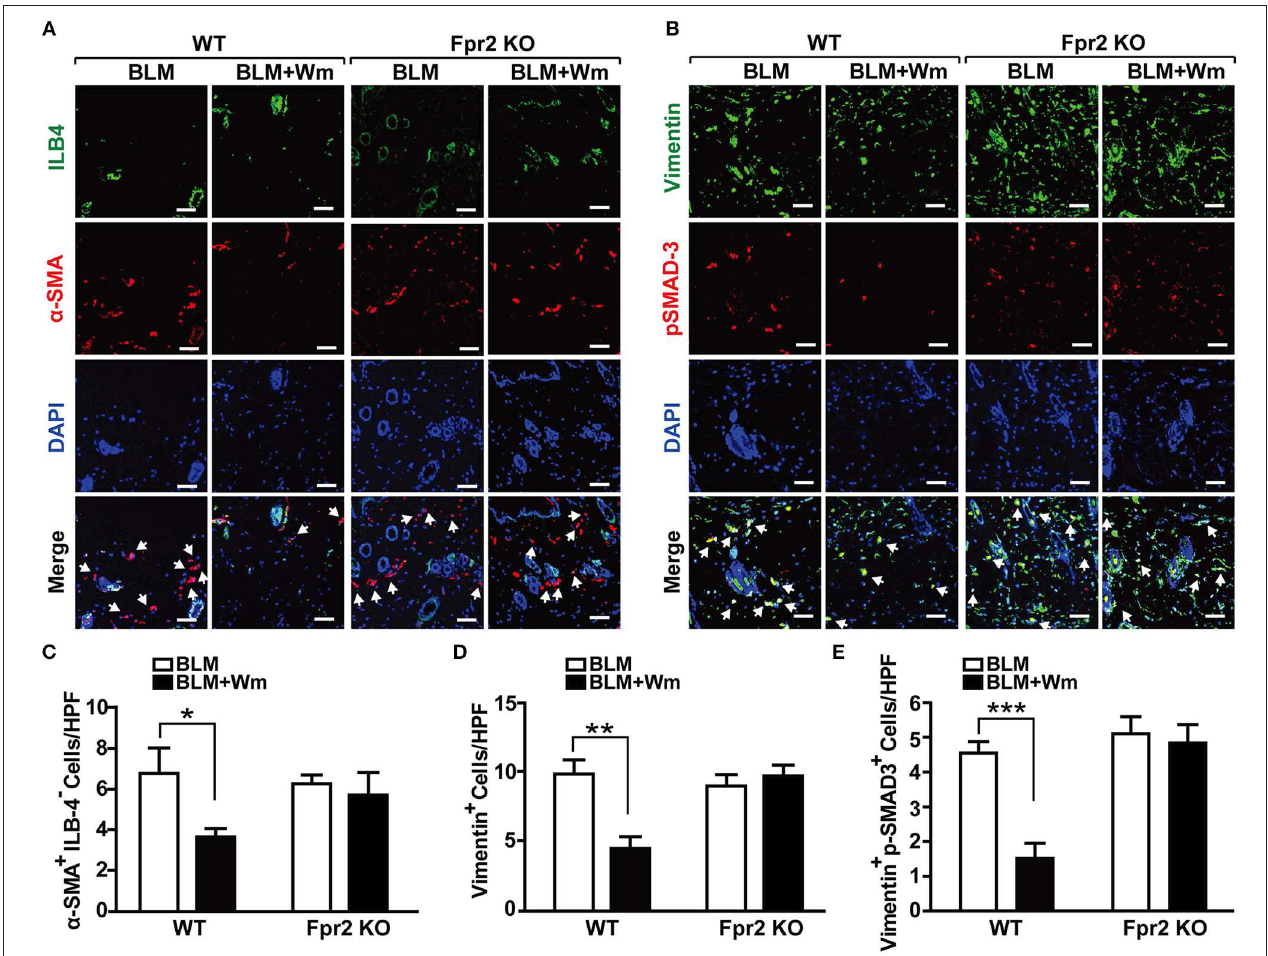
FIGURE 6 | The role of Fpr2 activation in the myofibroblast differentiation associated with scleroderma. (A) The BLM-induced scleroderma model of wild type and Fpr2 KO mice were daily injected with or without Wm for 3 weeks, followed by staining of the skin specimens with antibodies against α -SMA and ILB-4. (B) The skin specimens were stained with antibodies against Vimentin and phospho-SMAD3. Scale bar = 50 µ m. The numbers of α -SMA + ILB-4 − (C) , Vimentin + (D) , and Vimentin + phospho-SMAD3 + (E) cells were quantified under a high-power field. Data are shown as mean ± SD ( n = 8 per group). * p < 0.05, ** p < 0.01, *** p <